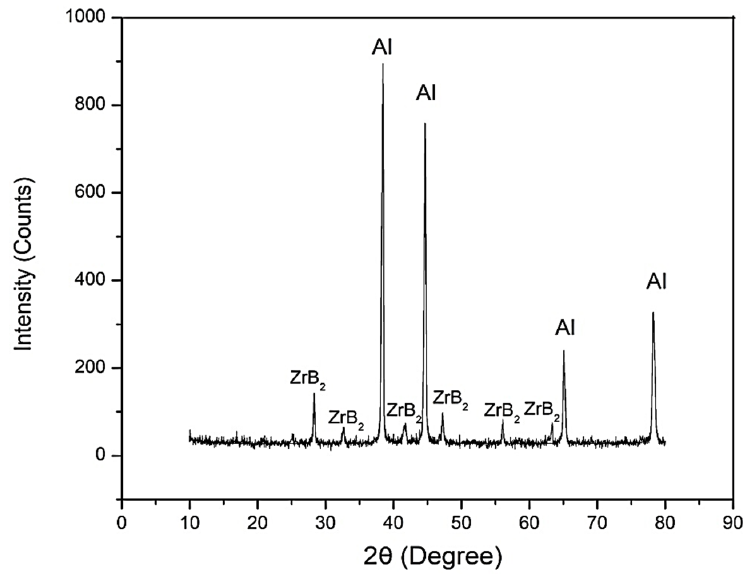
Figure 1. XRD of ADC12 with ZrB 2 reinforcement.